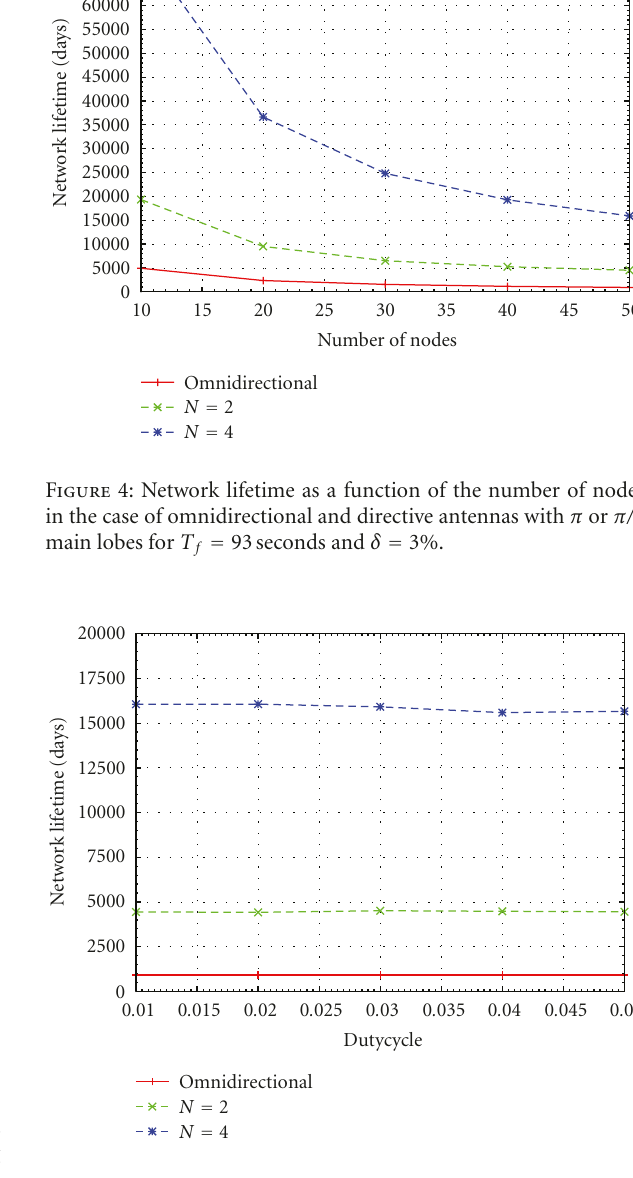
Figure 5: Network lifetime as a function of the duty cycle δ in the case of omnidirectional and directive antennas with π or π/ 2 main lobes for T f = 93seconds and 50